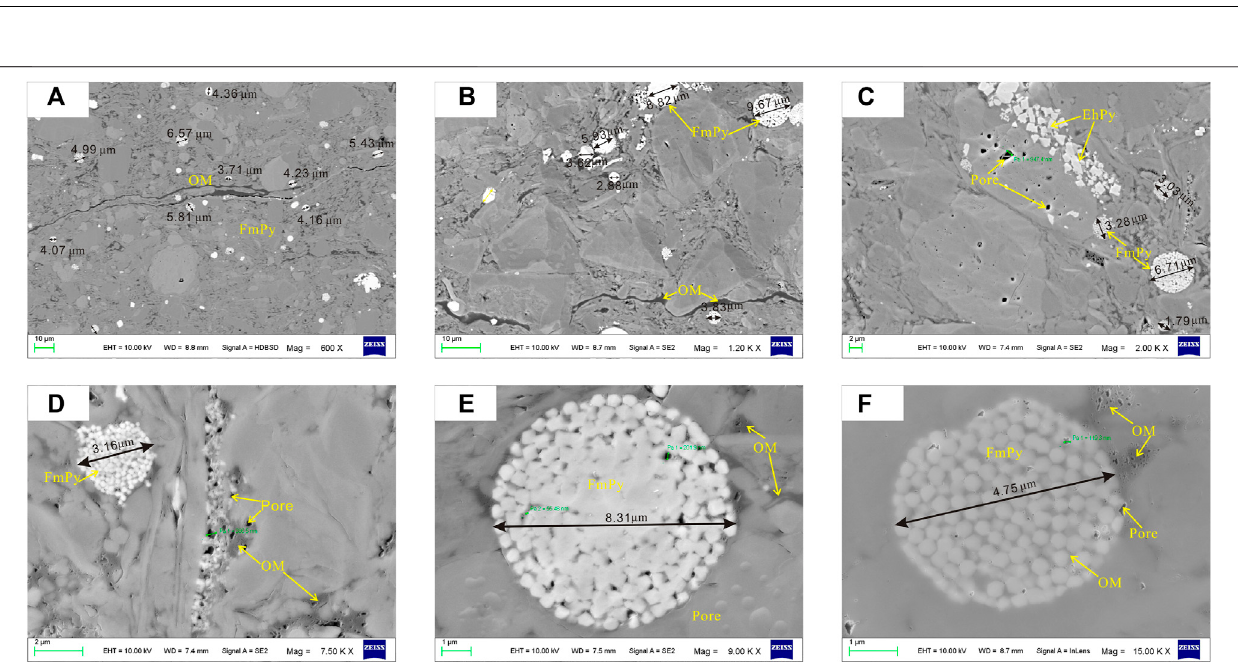
FIGURE3| Measurementofframboidalpyritediameters via Corephicv2.1software.PyritefromsamplesoftheLongmaxiFormation.OM=organicmatter;FmPy= framboidal pyrite; Ehpy = euhedral pyrite.